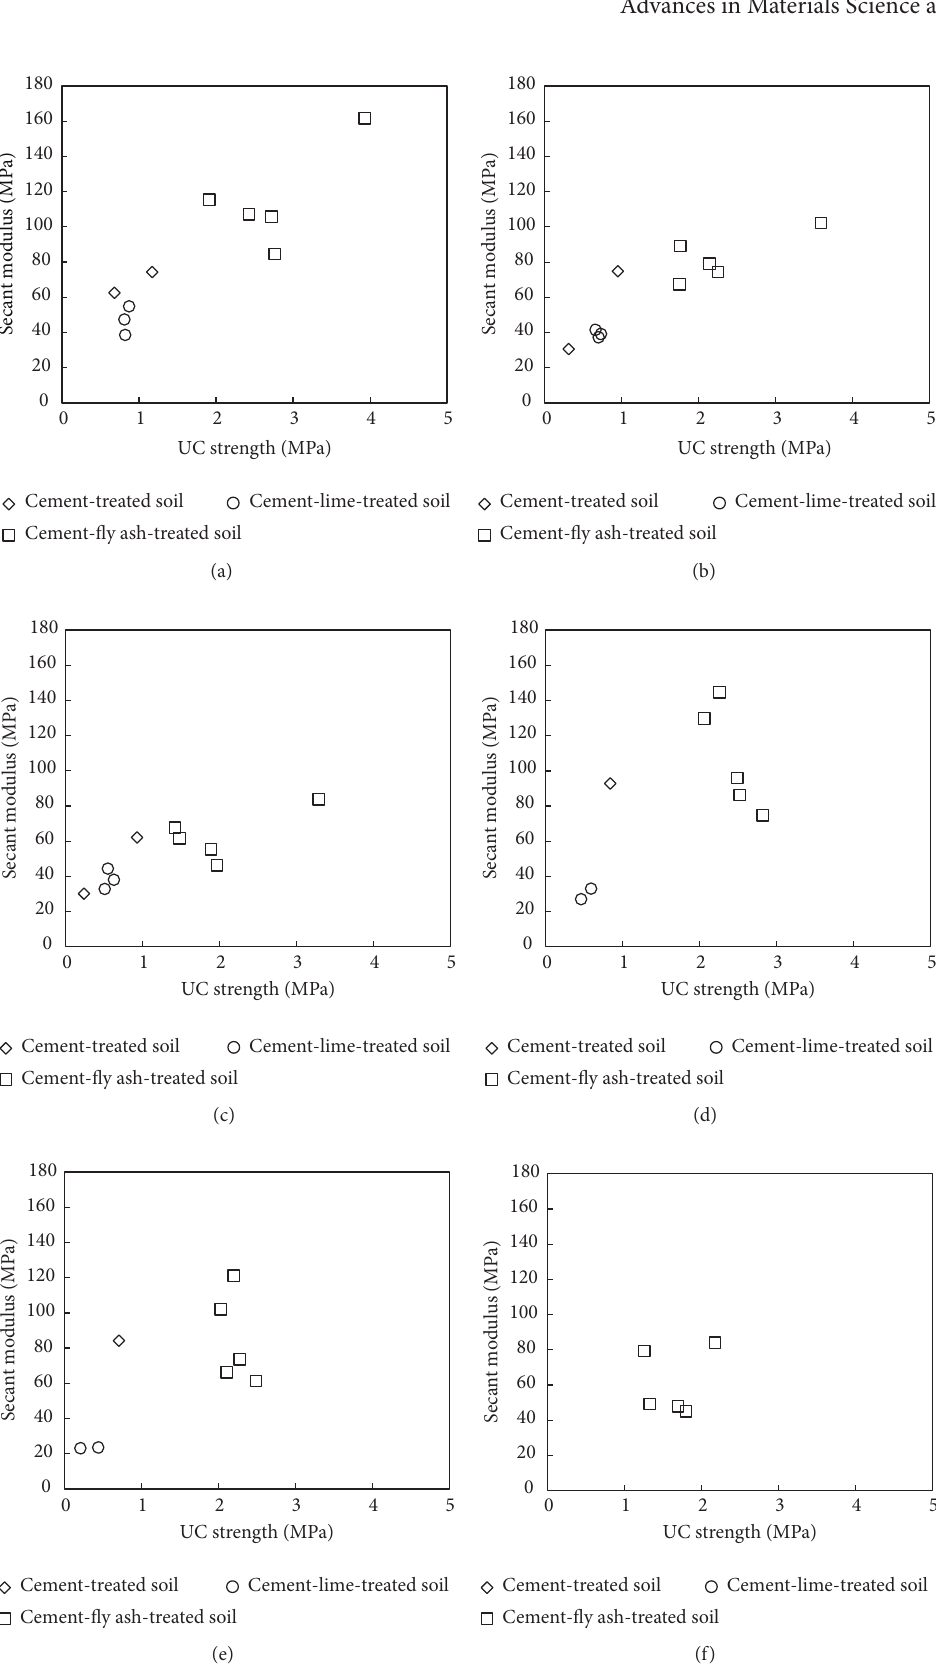
Figure 9: Secant modulus versus peak UC strength for samples subjected to different freeze-thaw cycles: (a) no frost actions, (b) 1 cycle, (c) 3 cycles, (d) 5 cycles, (e) 7 cycles, and (f) 9